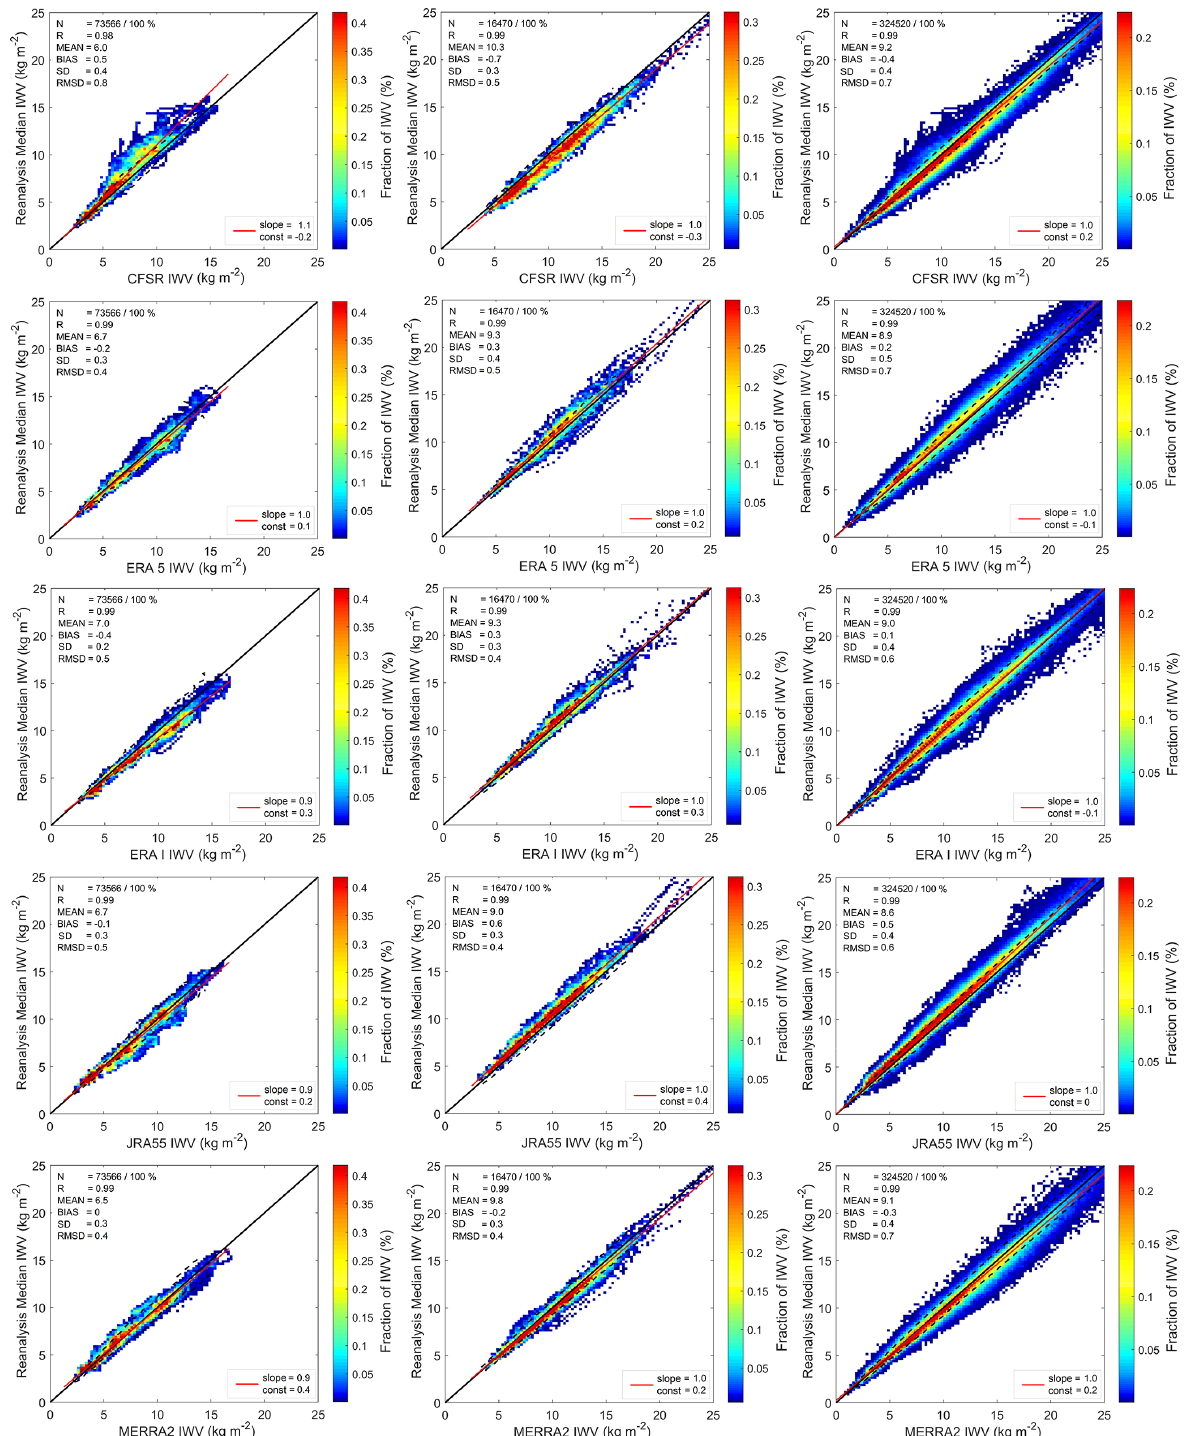
Figure A1. Joint distribution of daily means from the reanalyses ( x axis: CFSR, ERA5, ERA-Interim, JRA-55, MERRA2) and reanalysis median ( y axis: CFSR, ERA-Interim, JRA-55, MERRA2) for the central Arctic (left), open ocean (middle) and the full region (right). The time period is May to June 2017. The color indicates the relative fraction of the